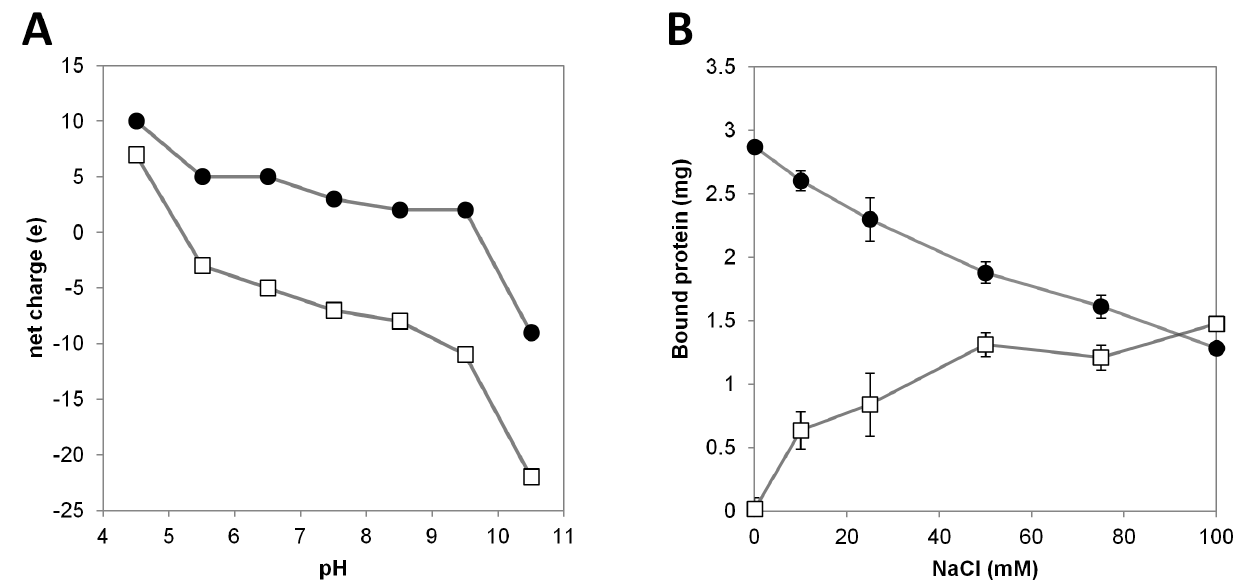
Figure 5. Expansins net charge depends on pH, and ionic strength determines their interaction with cellulose. (a) Theoretical net charge of the proteins at different pH values: full circles correspond to BsEXLX1 and open squares to PcExl1. (b) Ionic strength effect on binding to Avicel was determined experimentally, by incubating 1 mg of substrate with 5 m g of expansins (BsEXLX1, full circles; PcExl1, open squares) for one hour. Results are the arithmetic mean and standard deviations of three independent experiments.